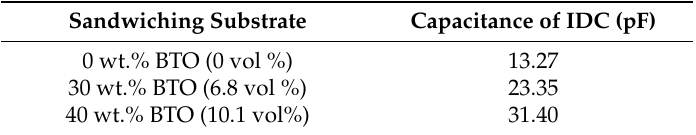
Table 2. The measured capacitance of the IDC sandwiched between different substrates.